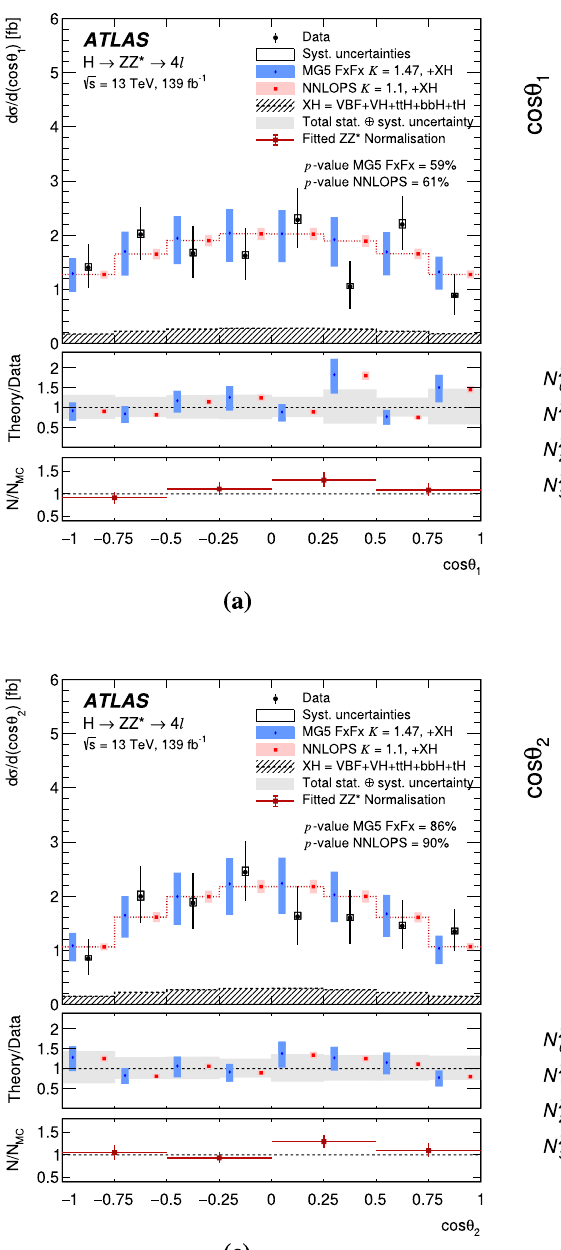
responding correlation matrices between the measured cross sections andthe Z Z ∗ background normalisationfactorsarealsoshown( b and d